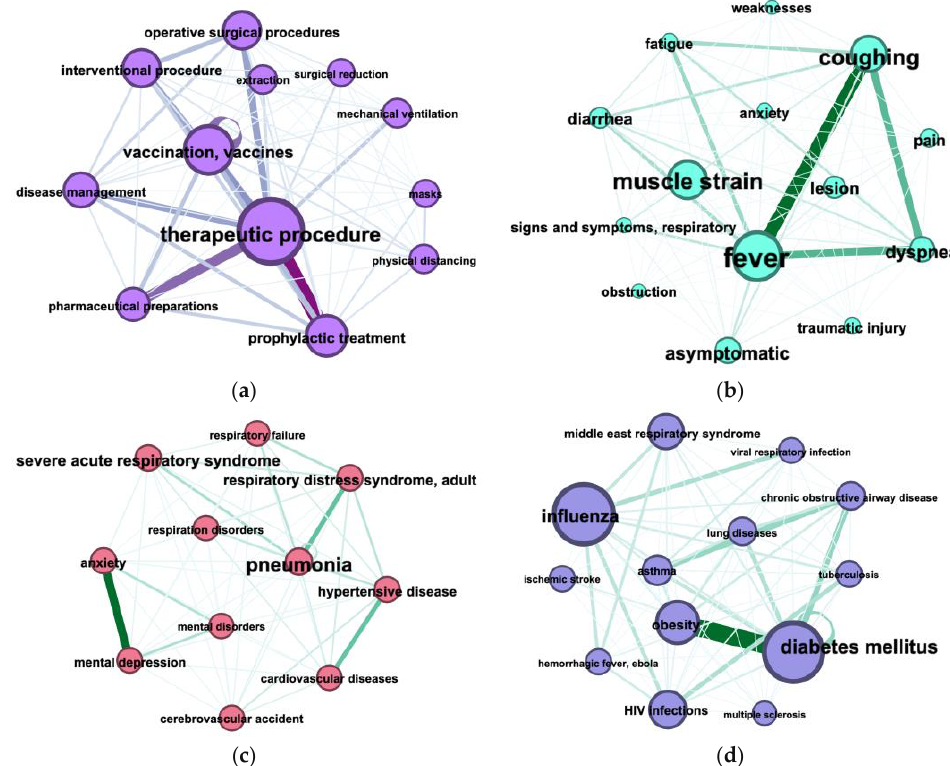
Figure 9. The connection between named entities in COVID-19 articles from 1 January 2019 to 1 February 2020 The node and font size corresponds to the number of entities’ mentions; the color and thickness of the edge correspond to the number of connections between entities. ( a ) treatments (including UMLS semantic types: “Therapeutic or Preventive Procedure”, ”Health Care Activity”, “Pharmacologic Substance”, ”Medical Device”); ( b ) signs or symptoms (including UMLS semantic groups: “Injuries and Poisonings”, “Pathologic Functions”, “Immunologic Factors”); ( c ) diagnoses (including UMLS semantic groups: “Disease or Syndrome”, “Mental or Behavioral Dysfunction”) concomitant COVID-19 (i.e., those that may be caused by a coronavirus infection); ( d ) diagnoses (including UMLS semantic groups: “Disease or Syndrome”, “Mental or Behavioral Dysfunction”) unrelated directly COVID-19.